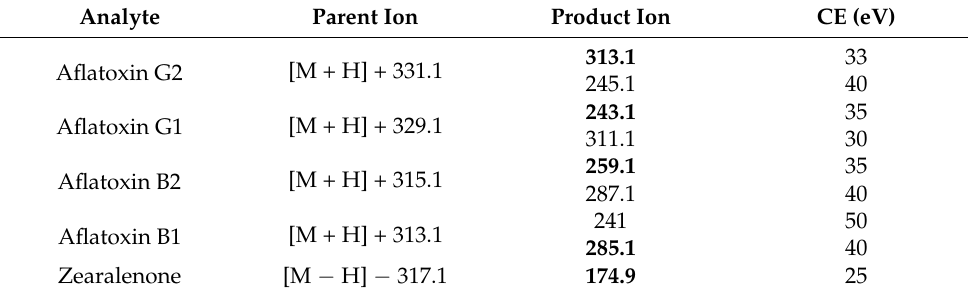
Table 1. MS/MS parameters for aflatoxins and zearalenone